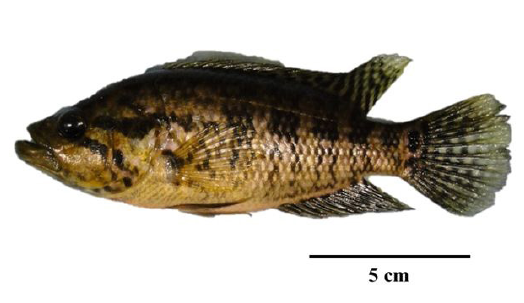
Figure 1. Specie P. managuensis collected in at the Saco I dam,